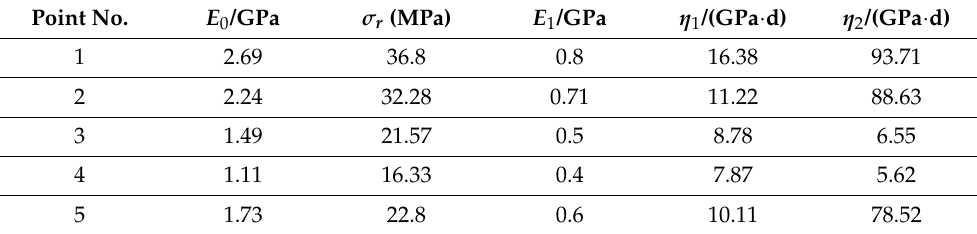
Figure 15. Measured displacement vs. time at each monitoring point. Table 7. Creep parameters of the rock mass at each monitoring Table 7. Creep parameters of the rock mass at each monitoring point.